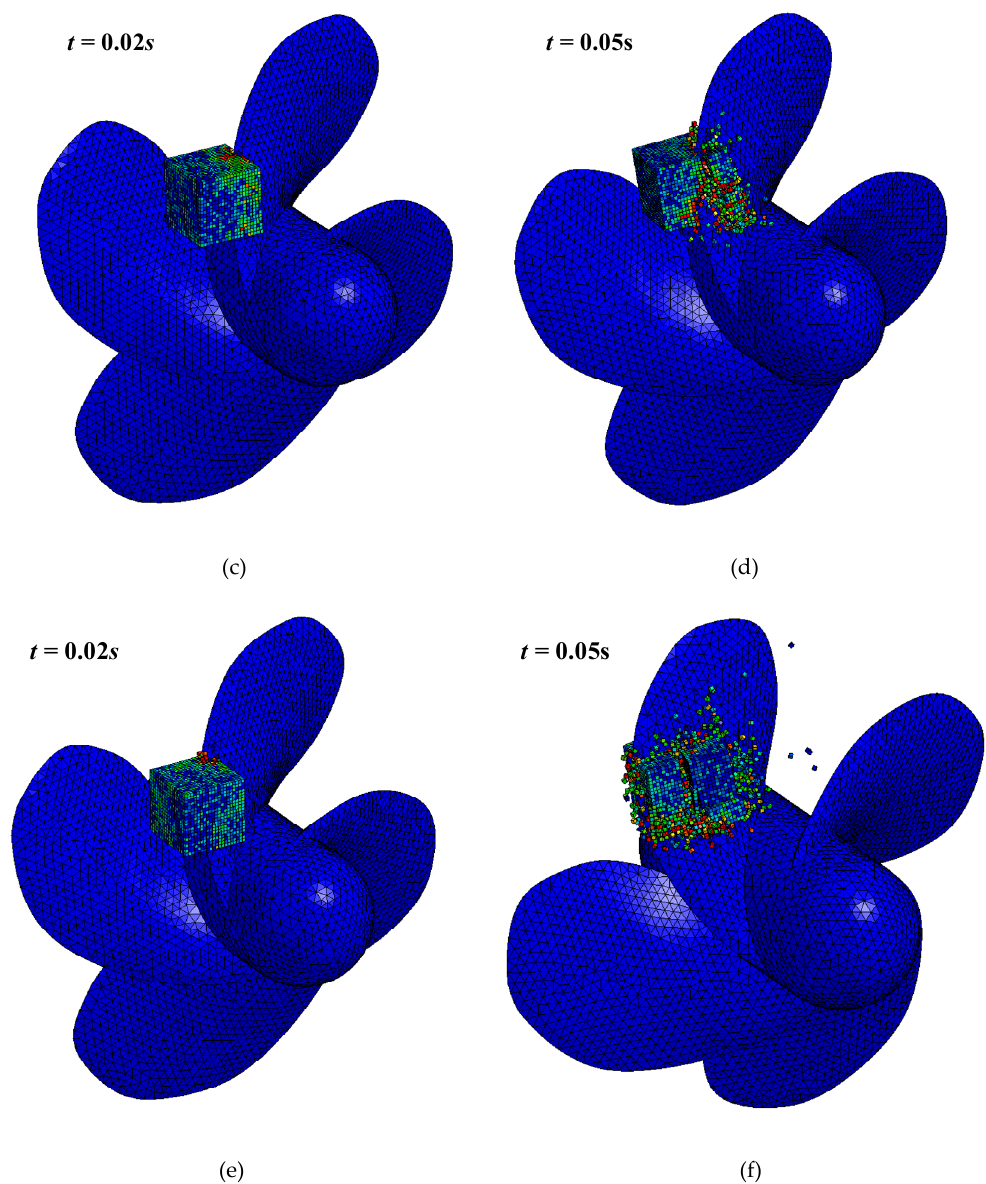
Figure 24. Stress nephograms of simulations for collision location at Loc2 with di ff erent rotation speeds. ( a ) The ice impact simulation at 0.02 s with 1 rps. ( b ) The ice impact simulation at 0.05 s with 1 rps. ( c ) The ice impact simulation at 0.02 s with 2 rps. ( d ) The ice impact simulation at 0.05 s with 2 rps. ( e ) The ice impact simulation at 0.02 s with 3 rps. ( f ) The ice impact simulation at 0.05 s with 3